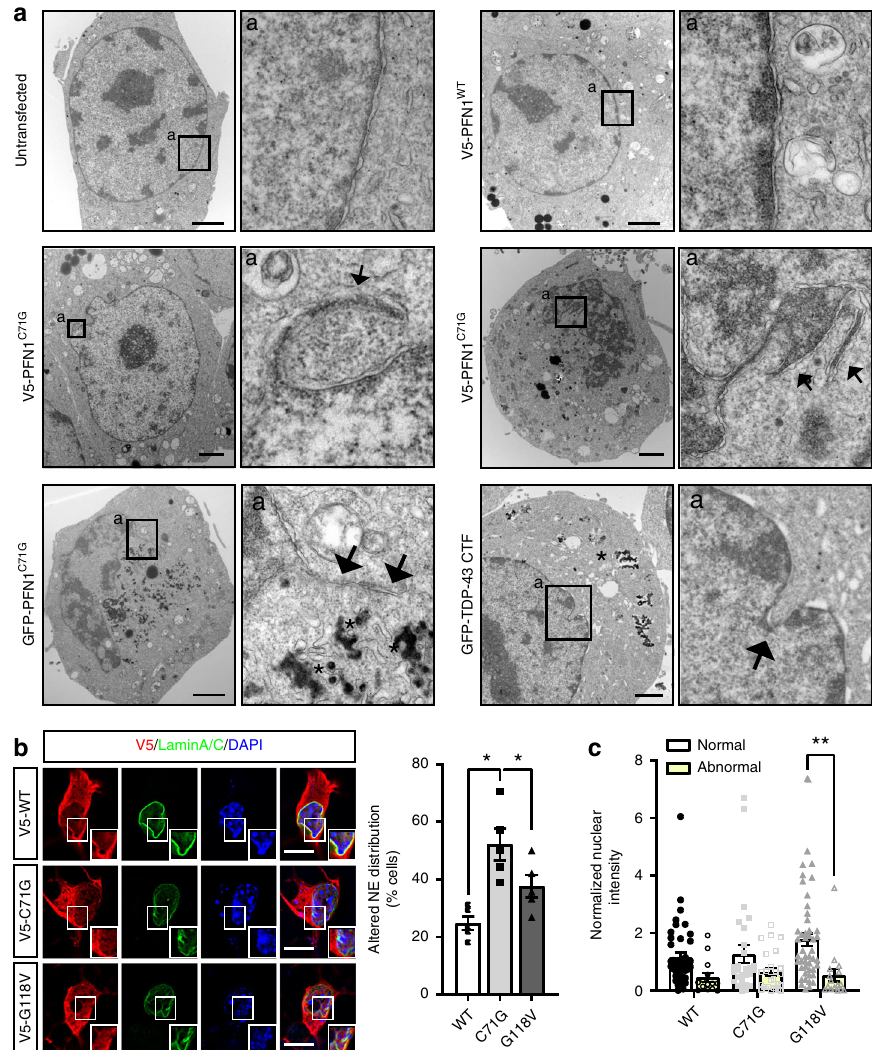
Fig. 2 The nuclear membrane integrity is compromised by mutant PFN1. a Transmission electron microscopy shows the presence of protrusions and folds (arrows) in Neuro2a cells expressing V5- or GFP-tagged PFN1 C71G compared to untransfected (Untr.) or PFN1 WT cells, similar to what observed in the presence of TDP-43 C-terminal fragment (CTF). Arrows point to anomalous membrane structures in the nucleus. Aggregates (asterisks) are visible as dark amorphous structures in the cytoplasm. b Lamin A/C (green) distribution at the NE is altered in a higher percentage of mutant PFN1 MNs. c Overall nuclear levels of Lamin A/C also appear slightly reduced in cells with abnormal staining. Boxes indicate areas enlarged in insets. DAPI (blue) was used to detect the nucleus and assess cell health. Scale bars: 2 µ m in ( a ), 10 µ m in ( b ). Bars are mean ± SEM; * p < 0.05, ** p < 0.01. N = 5 independent experiments ( b ) and 14 – 47 cells from 5 independent experiments ( c ). See also Supplementary Fig. 2 and Supplementary Table 1 for details on